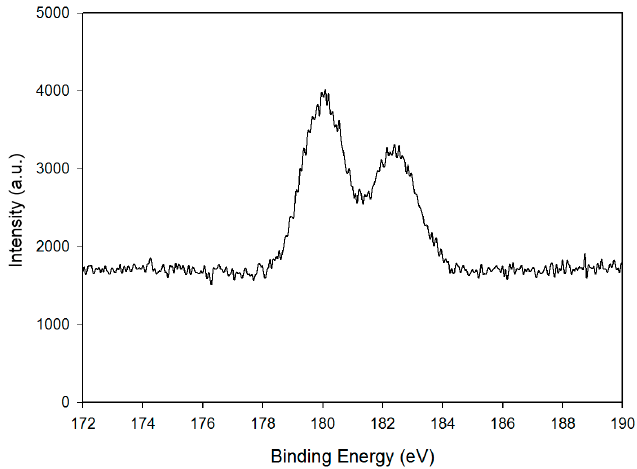
Figure 5. X-ray photoelectron spectrum of Zr/HNT.